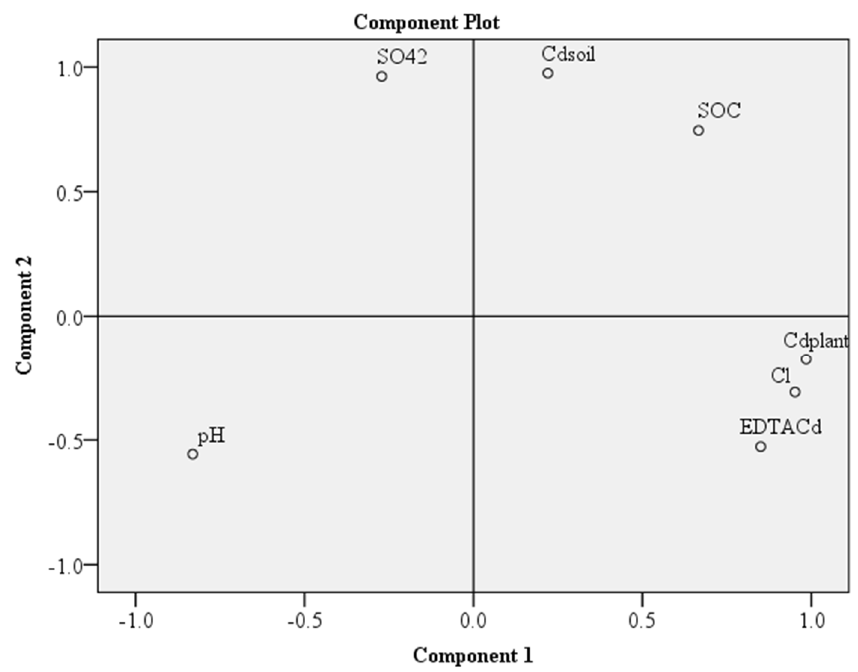
Figure 4. PCA analysis for the long-term experiment exhibited biplots for total 7 variables which showed that the first principle component (PC1) accounted for 55.0% and the second principle component (PC2) accounted for 45.0%. pH = soil pH, SOC = soil organic carbon, EDTA Cd = EDTA extractable Cd in soil, Cl = total Cl − contents in soil, SO42 = total SO 42 − content in soil, Cd plant = total Cd in rice grain.